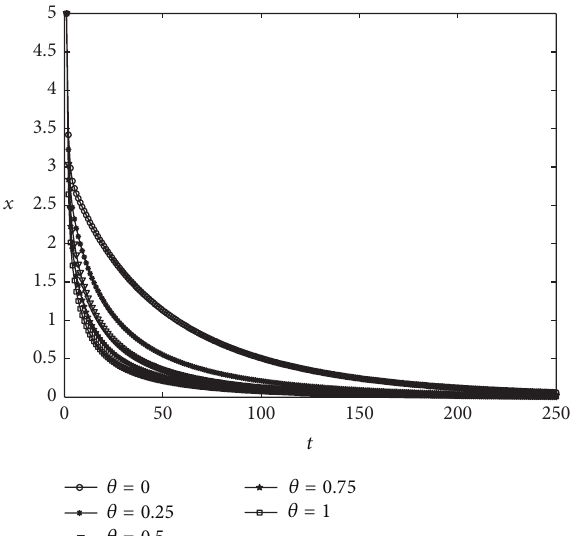
Figure1:Illustrationoftheeffectsofpesticideapplicationtimingontheextinctionofthehostpopulation.Theparametervaluesareasfollows: = 0.5 , 𝐾 = 50 , 𝛿 = 0.3 , 𝑞 = 0.94 , 𝛾 = 1 , 𝛼 = 0.007 , and 𝑟 = 2.8 𝑇 = 10 , 𝑇 ℎ